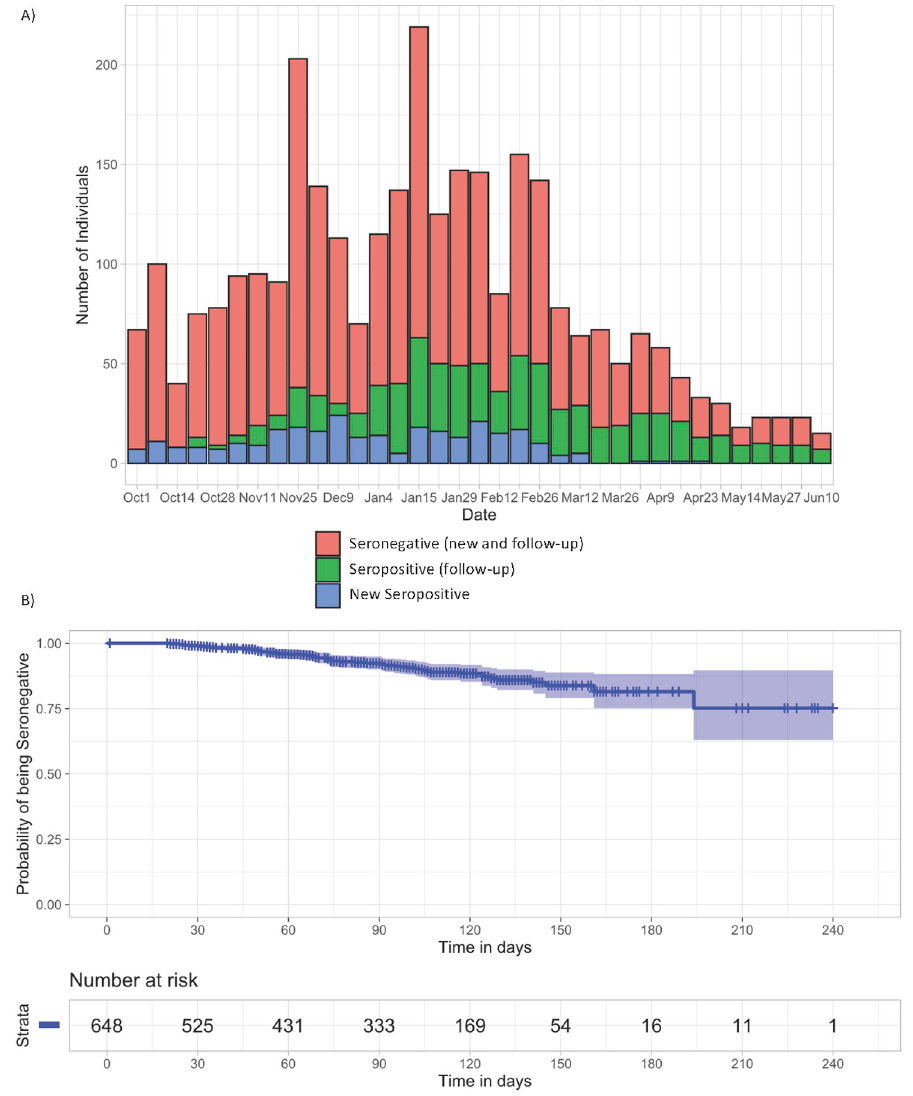
Fig 1. Variation of enrolment and SARS-CoV-2 seropositivity rate along the study period in healthcare workers of the two largest COVID-19 referral hospitals in Mexico City, October 2020-June 2021. A. Sampling distribution along the study period (October 2020-June 2021). New seropositive participants correspond to those having a positive serological test result in the first visit; seropositive follow-up corresponds to those having a positive serological test from the second visit onwards; seronegatives include both new and follow-up. B. Kaplan-Meier curve showing the unadjusted probability of being seronegative along time.